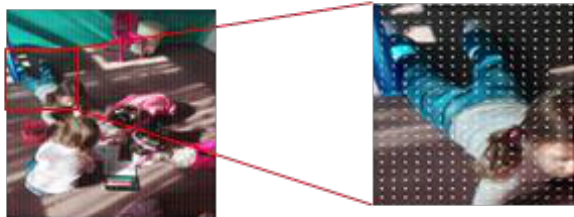
Figure 1. An example of a gradient image created using the HOG feature UAVs move in a 3D world. A drone's camera undergoes rolling,